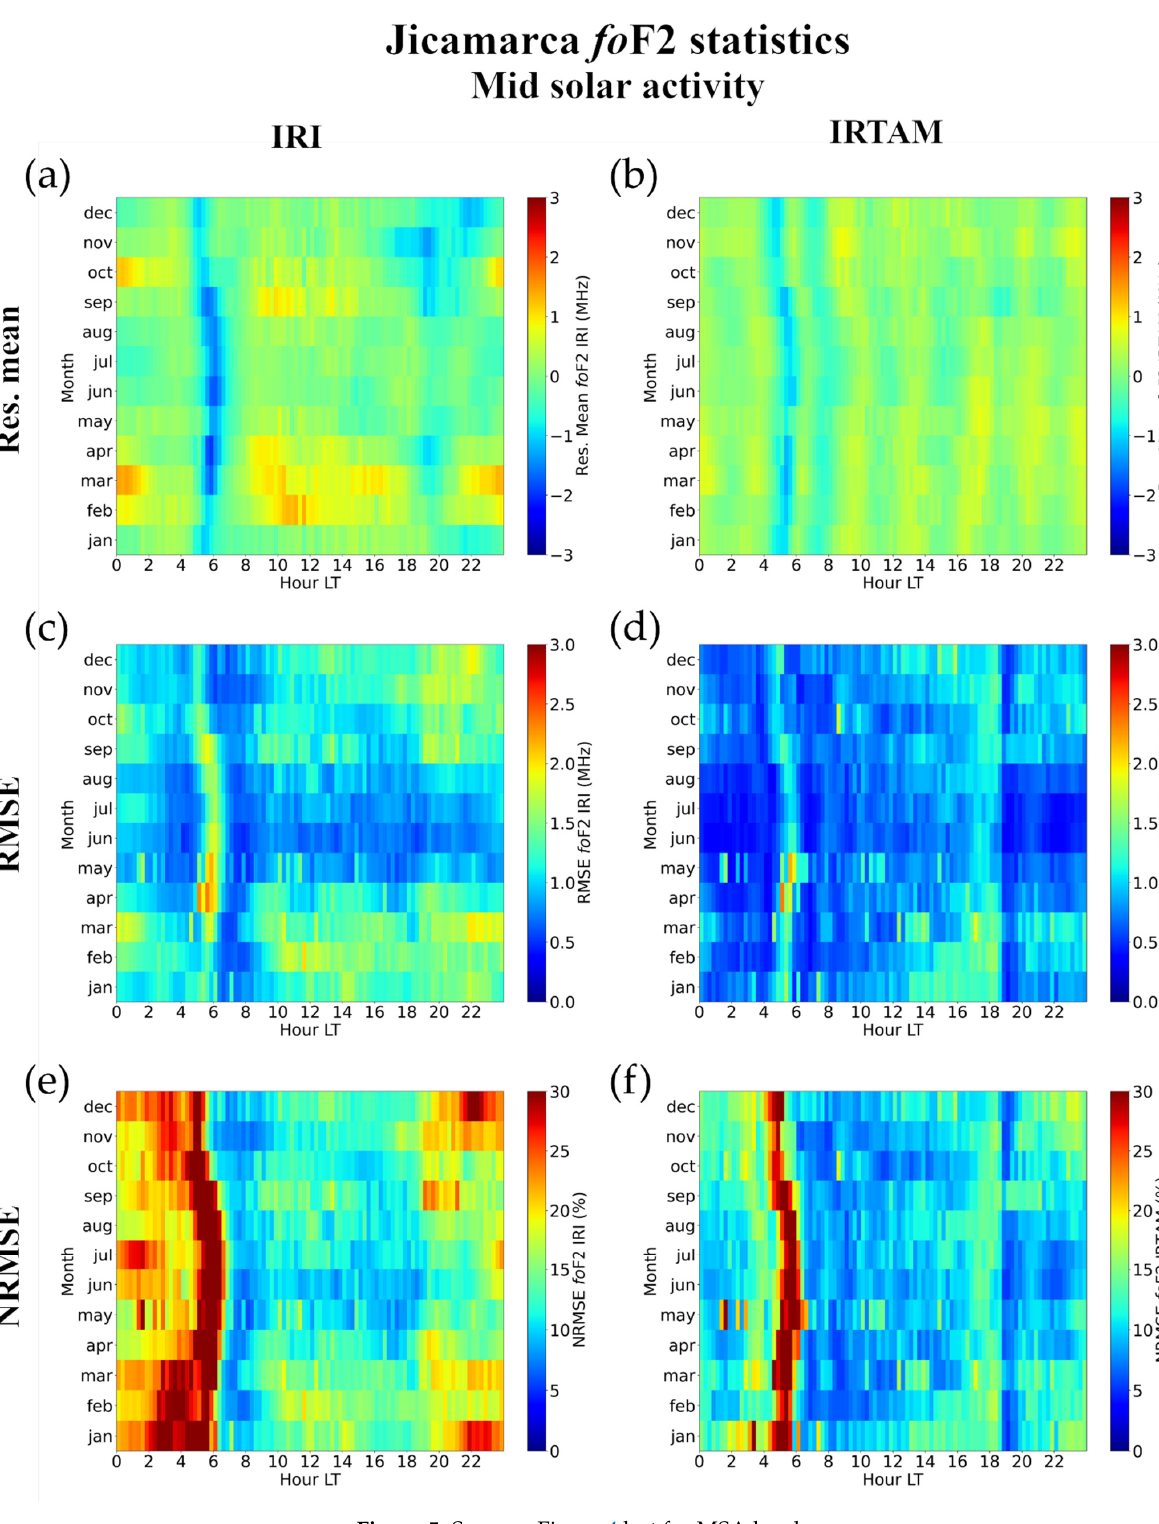
Figure 5. Same as Figure 4 but for MSA level.